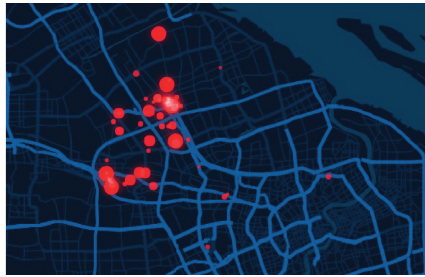
Figure 7: Network and demand intensity for case